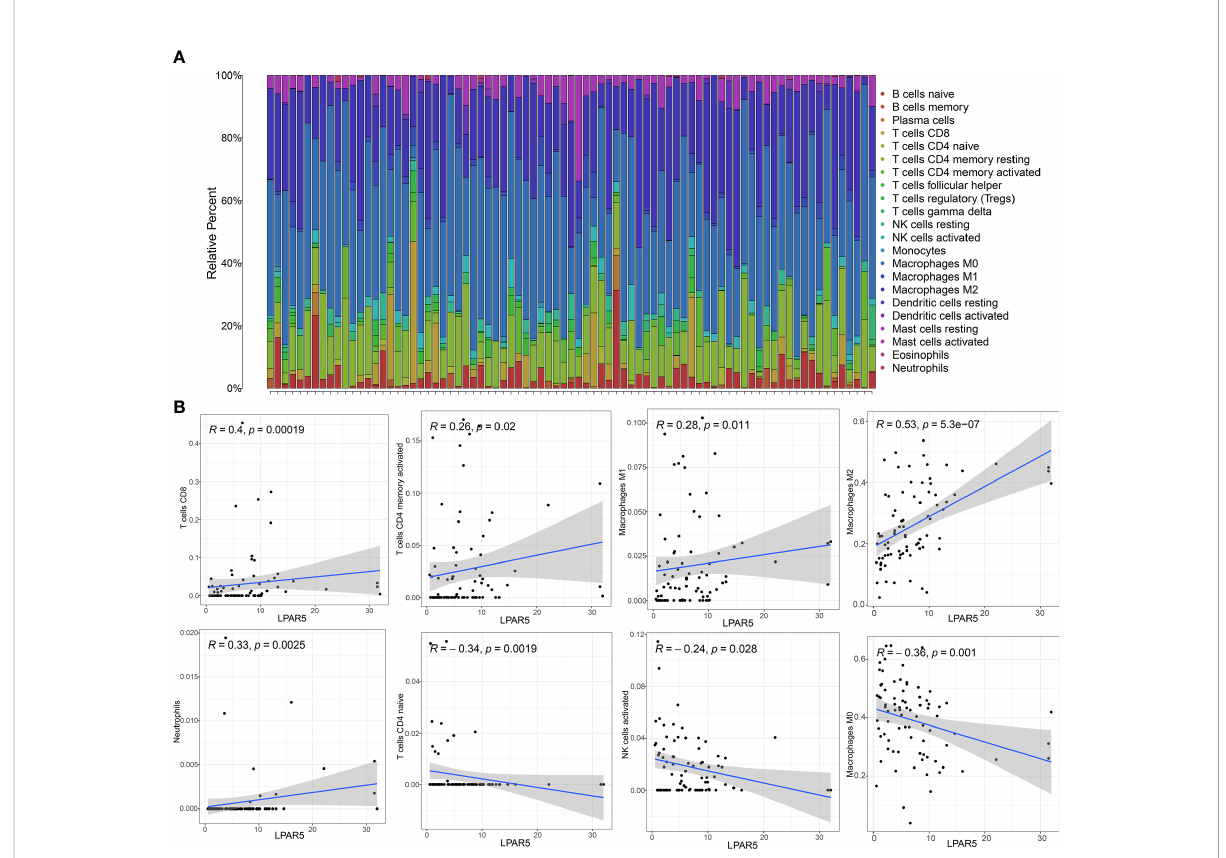
FIGURE 7 Immune-in fi ltration analysis by using CIBERSORT algorithm. (A) A barplot showing the proportion of TIICs in all osteosarcoma samples. (B) A scatter plot showed the correlation of CD8 + T cells, CD4 + activated memory T cells, M1 macrophages, M2 macrophages, neutrophiles, CD4 + naive T cells, activated NK cells and M0 macrophages with the LPAR5